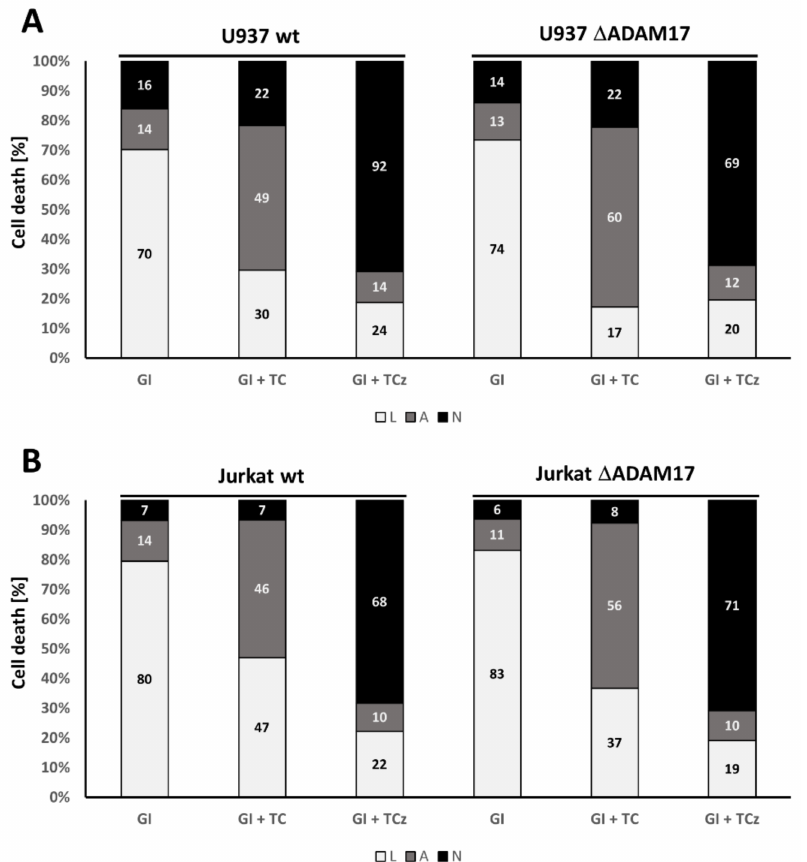
Figure 5. Analysis of ADAM10 in ∆ ADAM17 cells. Quantification of cell death is shown in ( A ) U937 wt vs. ∆ ADAM17 (clone 3) and ( B ) Jurkat cells. GI254023X (GI) was used to inhibit ADAM10 activity. The percentage of living (L, white), apoptotic (A, grey) and necroptotic (N, black) cells are shown. One representative of at least n = 3 experiments is